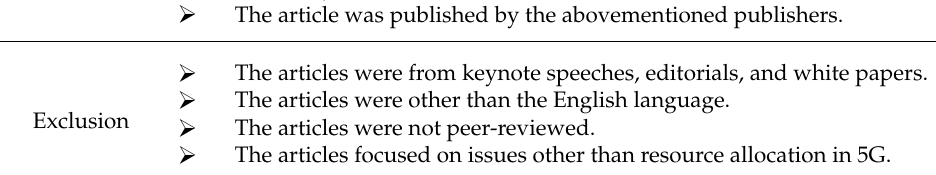
Table 3. Inclusion and exclusion criteria.